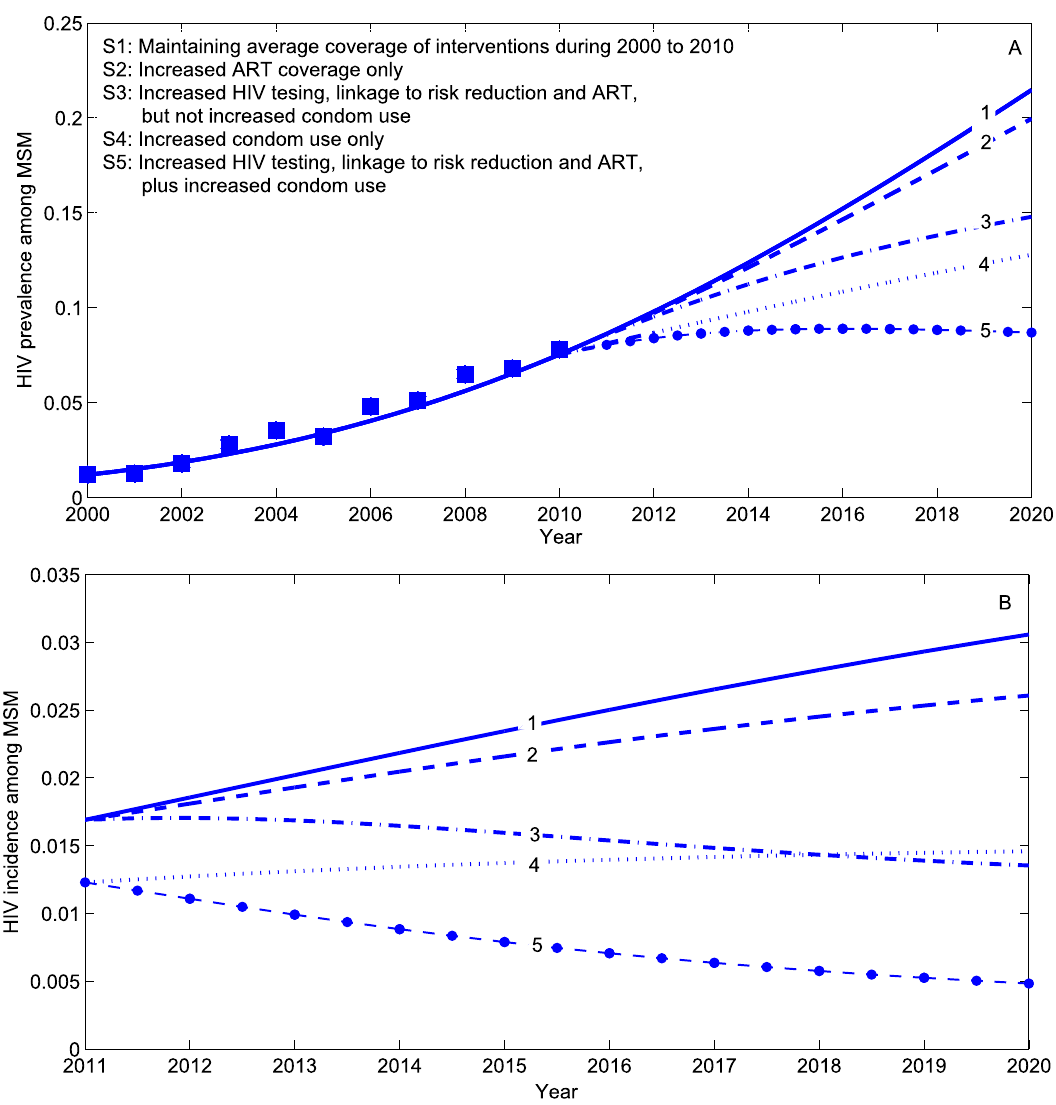
Figure 2. Predicted effects on HIV prevalence and incidence among Chinese MSM in five scenarios of HIV combination interventions. (A) effect on HIV prevalence; (B) effect on HIV